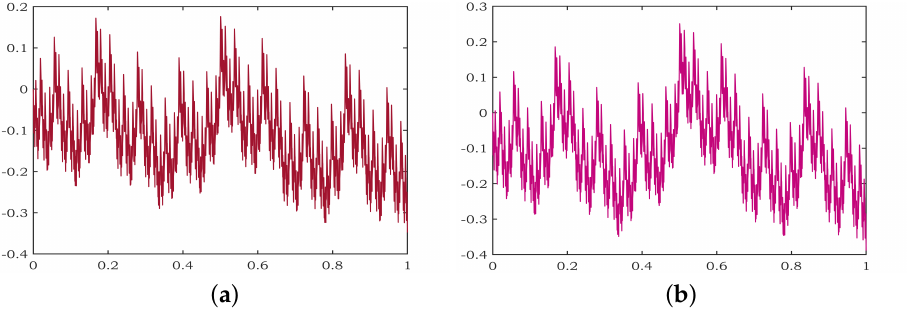
Figure 4. The WM fractional derivative: ( a ) D µ ( s ) f 1 with variable order µ ( s ) = 0.5, ( b ) D µ ( s ) f 2 with order µ ( s ) =